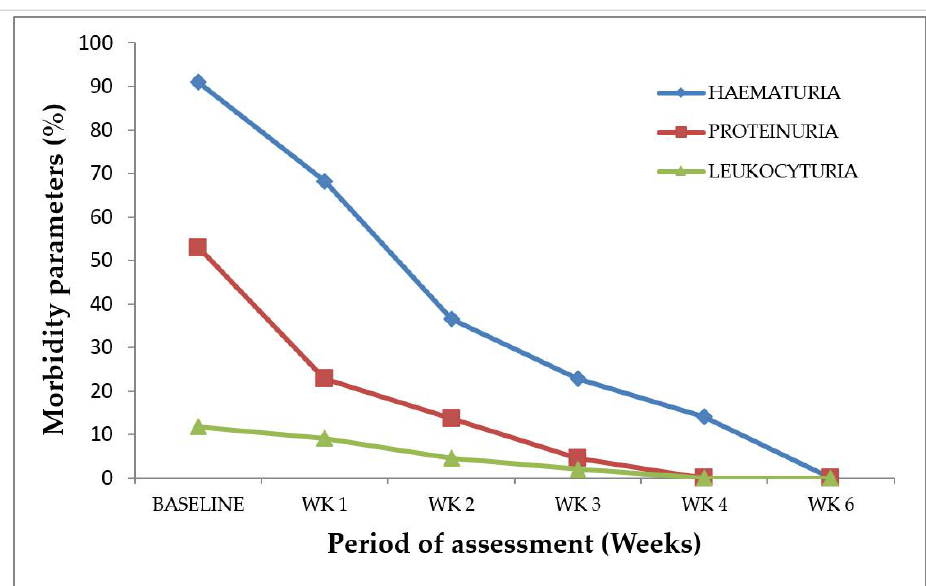
Figure 2. S. haematobium infection morbidity indicators at baseline and post-treatment. n = 30, WK represents week.